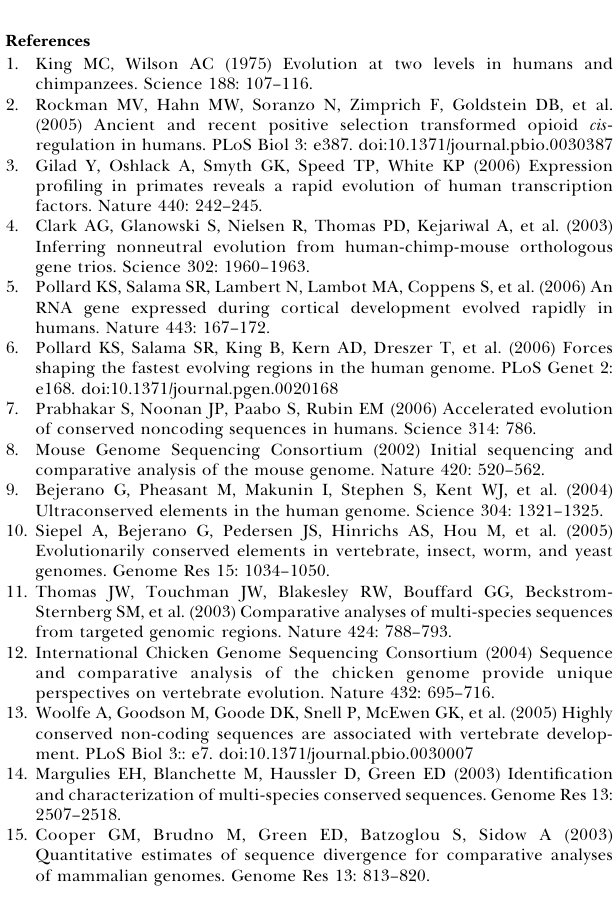
Table S11. Six Alternative Models in Which Each Tree May Be Split into Subtrees That Share a Single Rate, While the Rest of the Tree Has a Single Background Rate Table S12. Counts of CNCs That Are Classified As Having Two Rate Parameters by the Modified AIC Method Note that CNCs that show rate changes on the chimpanzee lineage but have low-quality chimpanzee sequence are not counted. Found at doi:10.1371/journal.pgen.0030147.st012 (43 KB DOC). Table S13. Locations of Neutral and Selected CNCs with Respect to Genes The table shows the fractions of amniotic CNCs either within introns or at three different distances from genes, within each selected group (neutral, rate speed-ups on a single lineage by SRT i , or by AIC). For each CNC, the nearest gene was found without considering gene orientation. Each intergenic CNC was divided into three groups that are 1) within 10 kb, 2) between 10 kb and 100 kb, and 3) greater than 100 kb from any gene. Table S14. Three Choices of Penalty Functions for the Two Classes of Models That Are Considered in the Modified AIC Each penalty is adjusted so that the null model (the number of parameters is one) has zero penalty. Table S15. Estimates of the Human-to-Chimpanzee Divergence